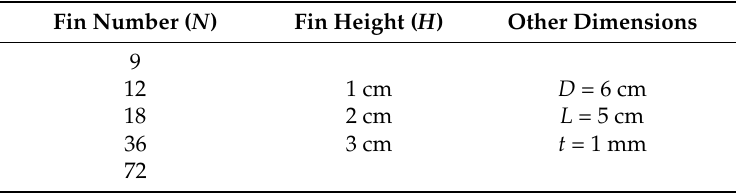
Figure 4. Photograph of experimental setup. Table 2. Dimensions of finned